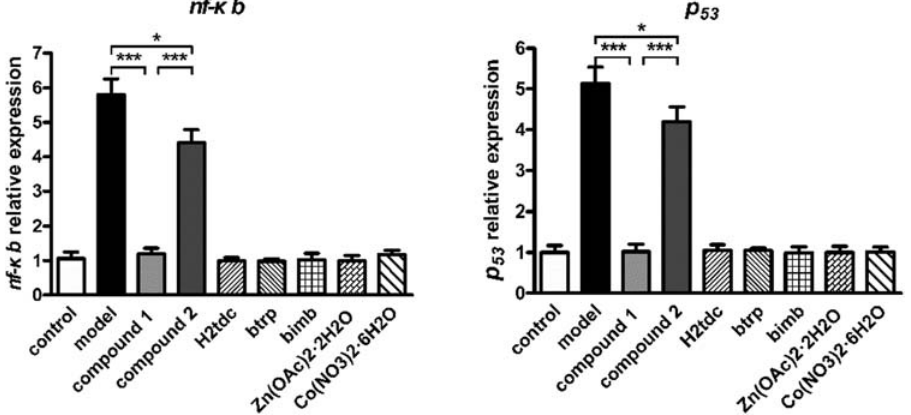
Figure 4: Reduced the expression level of in fl ammatory genes nf - κ b and p53 in periodontal mucosal cells. The periodontitis rat model was constructed, and then treated by compounds 1 and 2 at the concentration of 5 mg/kg. The expression level of in fl ammatory genes nf - κ b and p53 in periodontal mucosal cells was measured with real - time RT -